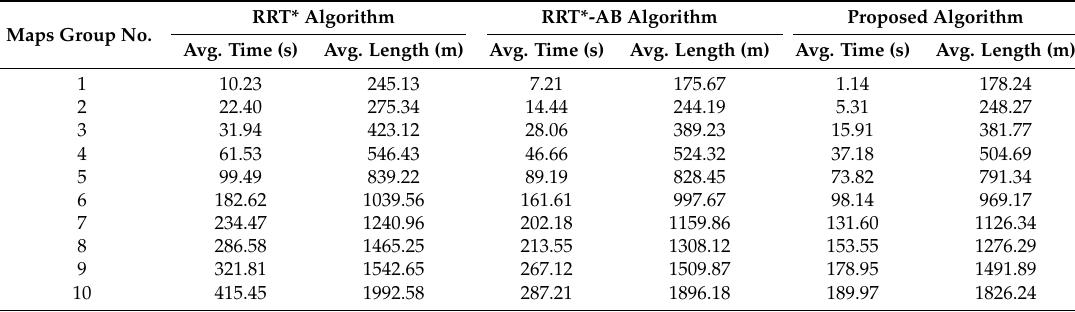
Table 3. Proposed algorithm pathfinding performance comparison with RRT* and RRT*-AB algorithms. Maps Group